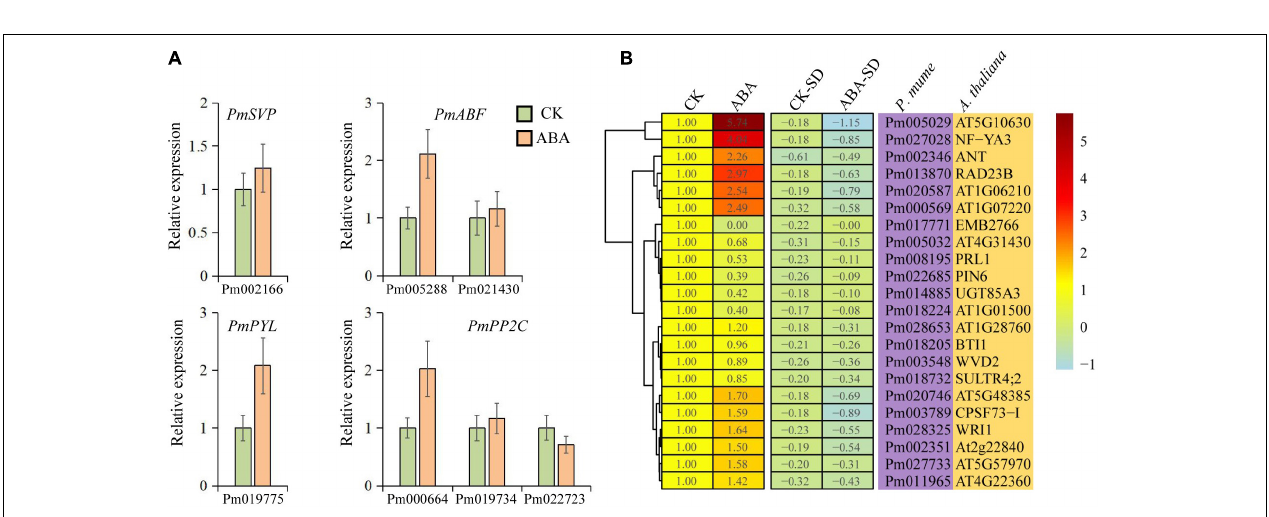
FIGURE 6 | Expression patterns of candidate genes under abscisic acid (ABA) treatment. (A) qRT-PCR of 7 selected genes under ABA treatment. (B) Heatmap of 22 genes under ABA treatment. CK represents the control group, ABA represents the ABA treatment group, and CK-SD and ABA-SD represent the standard deviations of relative expression levels in the groups,